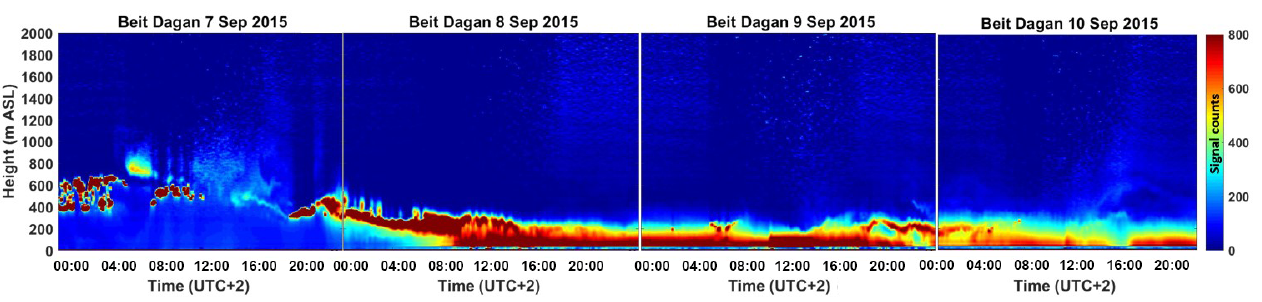
Figure 9. Beit Dagan ceilometer signal counts plots for 7–10 September 2015. The y axis is the height from site deployment to 2000ma.s.l., the x axis is in LST (UTC + 2), and the signal count scale ranges between 0 and 800.